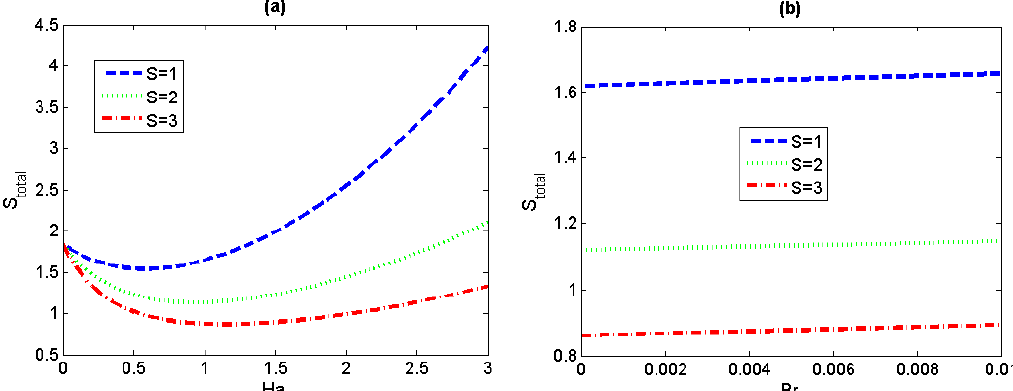
Figure 10. Variations of total entropy generation S total versus Ha and Br for different value of S ( Λ = 0.01, Pe = 0.5). ( a ) Br = 0.005; ( b ) Ha = 1.